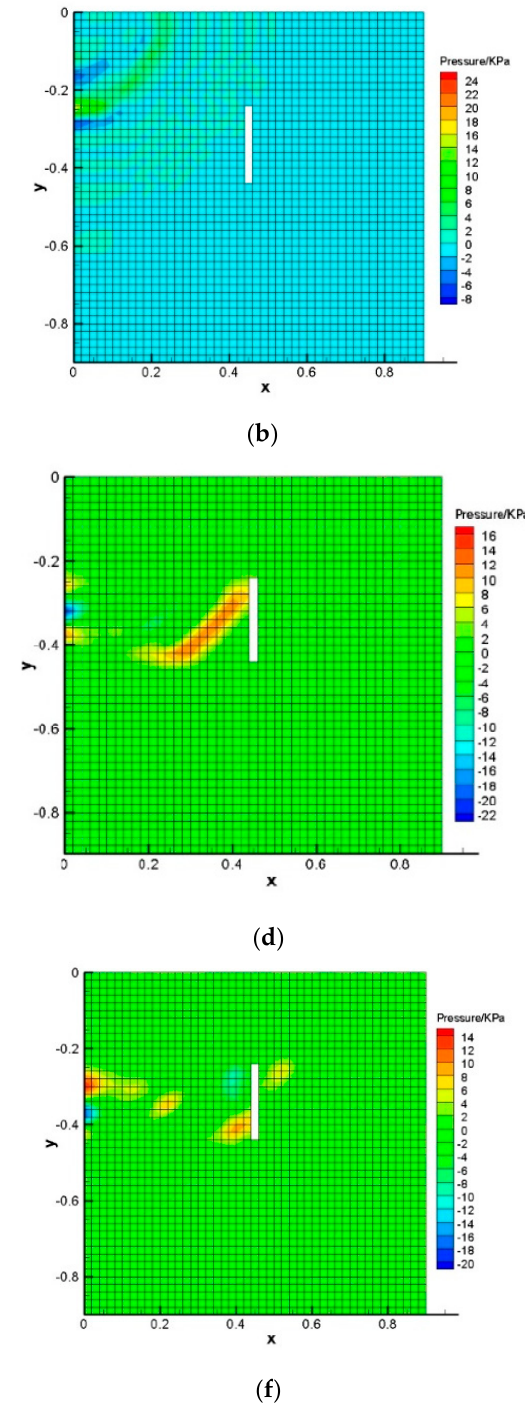
Figure 8. Pressure profiles between Newmark method and MDGFEM. ( a ) Newmark 0.15 μs ; ( b ) MDGFEM 0.15 μs ; ( c ) Newmark 0.3 μs ; ( d ) MDGFEM 0.3 μs ; ( e ) Newmark 0.45 μs ; and ( f ) MDGFEM 0.45 μs .